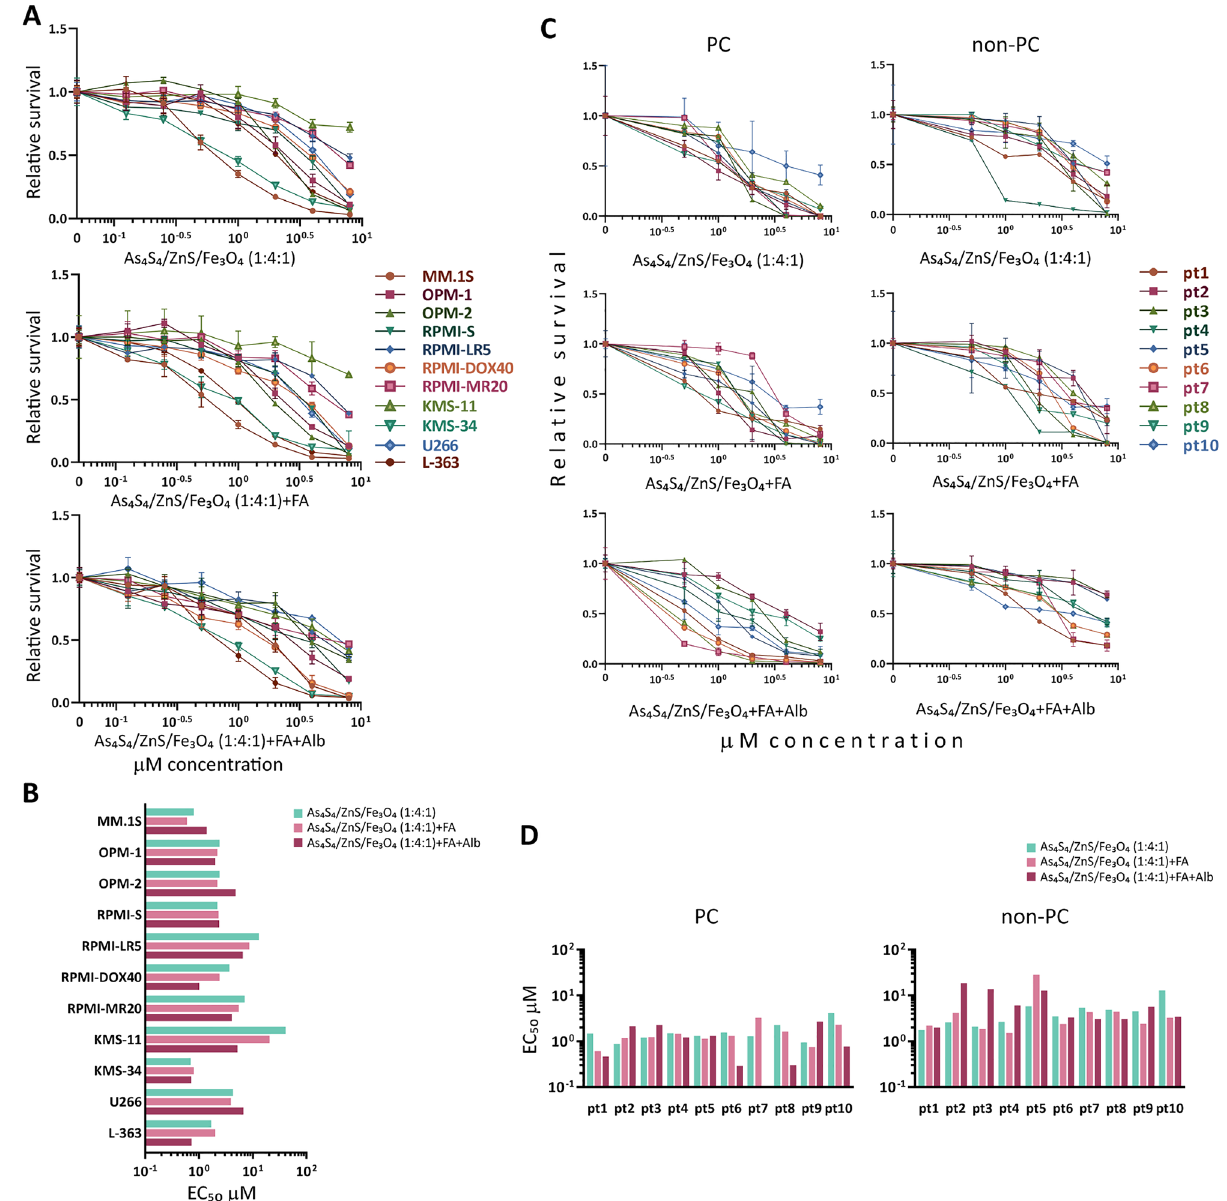
Figure 1. Cytotoxic effects of As 4 S 4 /ZnS/Fe 3 O 4 (1:4:1), As 4 S 4 /ZnS/Fe 3 O 4 (1:4:1) with FA, and As 4 S 4 /ZnS/ Fe 3 O 4 (1:4:1) with FA and Alb in MM cells. ( A ) MM cell lines (MM.1S, OPM-1, OPM-2, RPMI-S, RPMI-LR5, RPMI-DOX40, RPMI-MR20, KMS-11, KMS-34, U266, and L-363) were treated with all 3NPs in the concentrations: 0.125, 0.25, 0.5, 1, 2, 4, and 8 µM for 48 h and cell survival was analyzed by MTT assay. ( B ) The